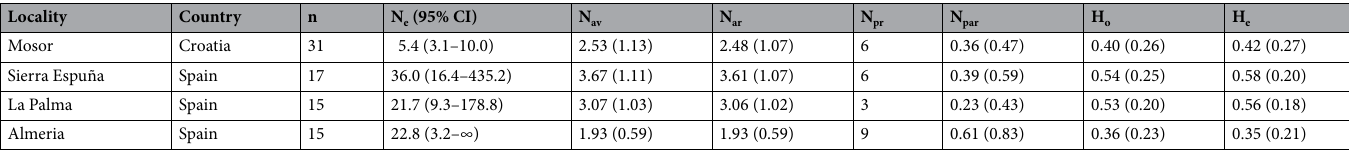
Table 1. Genetic diversity assessed from fifteen microsatellite markers in four European aoudad populations. n = number of successfully genotyped individuals per sampling population, N av = mean number of alleles per locus, N ar and N par = rarefied allelic and private allelic richness (smallest sample size = 28 alleles, as explained in materials and methods section), N pr = total number of private alleles, H o = observed and H e = expected heterozygosity, f = estimator of the inbreeding coefficient (none of the values were statistically different from 0, with P < 0.05).